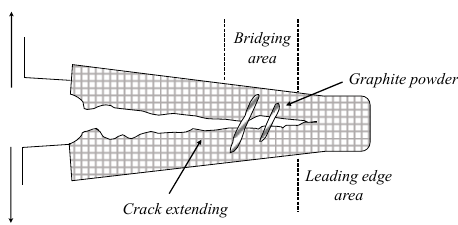
Figure 10. F-CMOD curves.